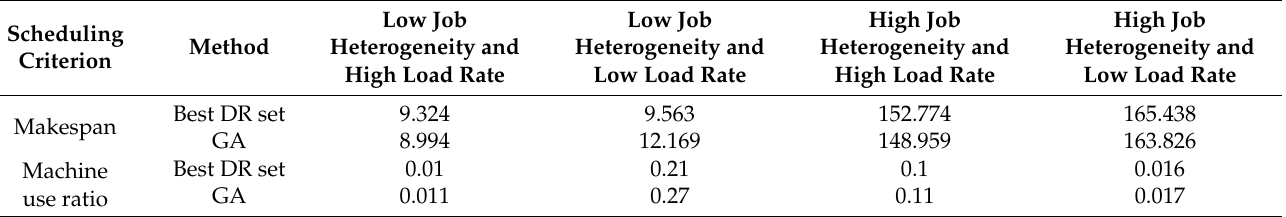
Table 8. Overall stability comparison of scheduling rule combination and genetic algorithm perfor-